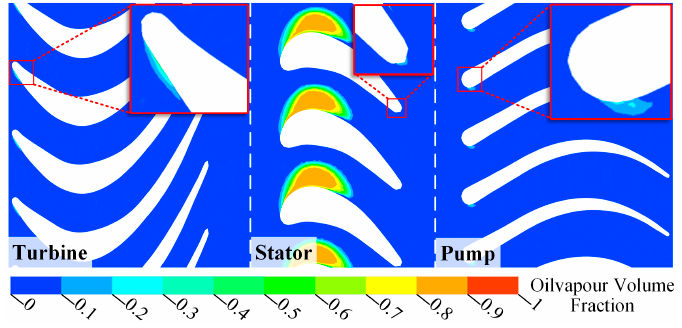
Figure 8. The vapor volume fraction distribution in torque converter at stall when N P = 3000 rpm.